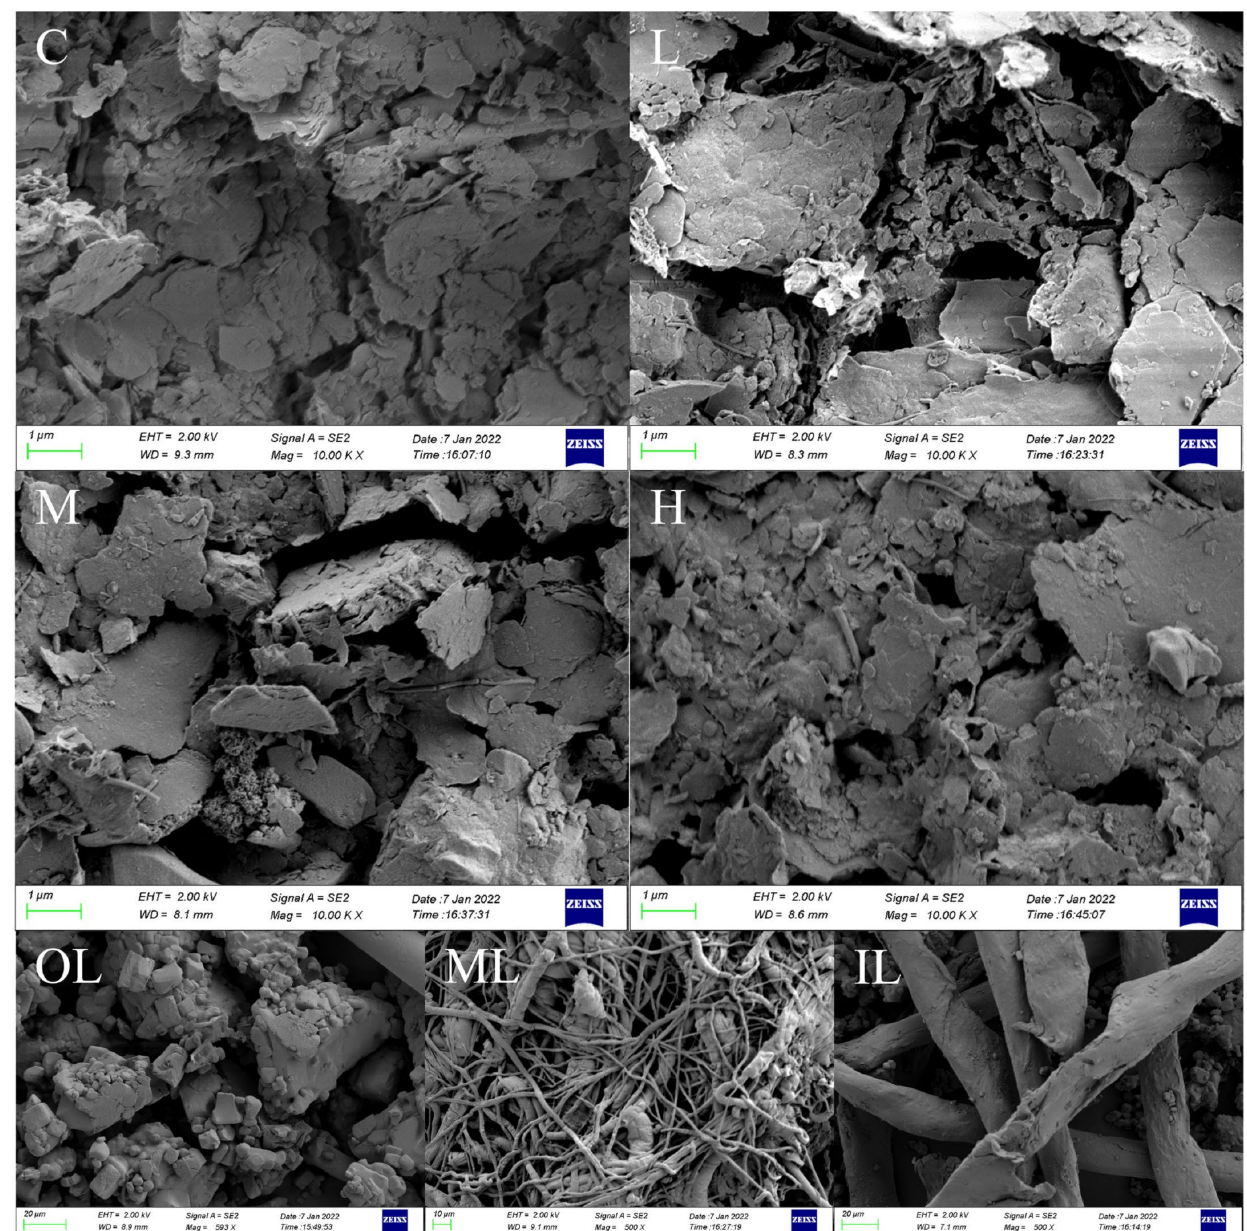
Figure 2. C, L, M, and H are the scanning electron microscopy images of microplastic particles in the control and experimental group collected samples, respectively; OL, ML, and IL are the SEM images of the outer, middle, and inner layers of the disposable medical mask,